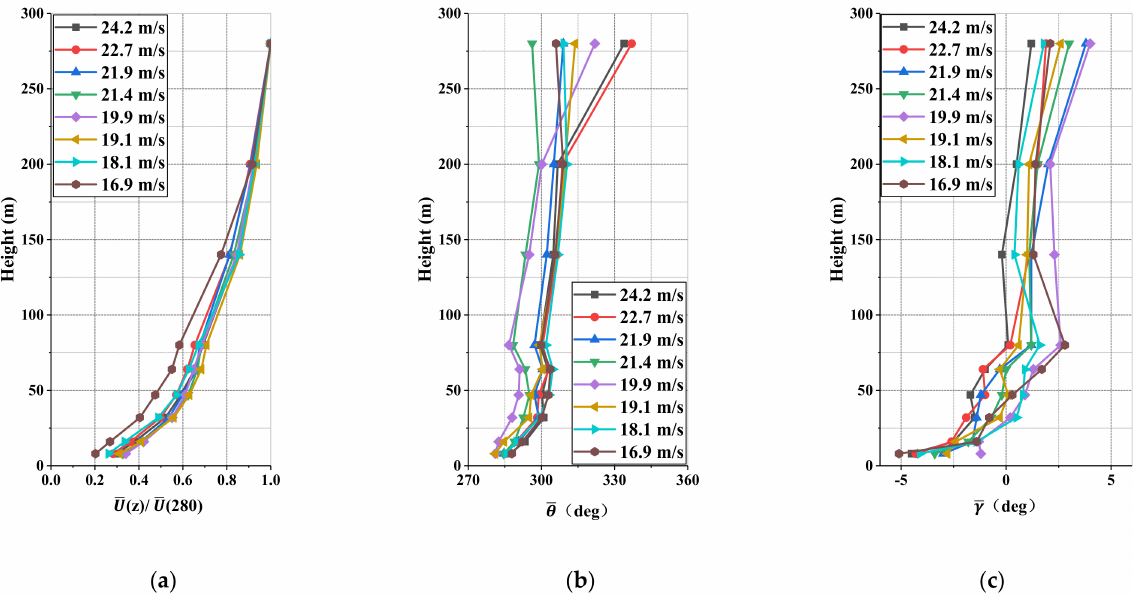
Figure 15. The profiles of the 10-min mean wind speed nomalized by the related value at 280 m ( a ), the horizontal direction ( b ) and the wind angle of attack ( c ) related to eight strong synoptic wind